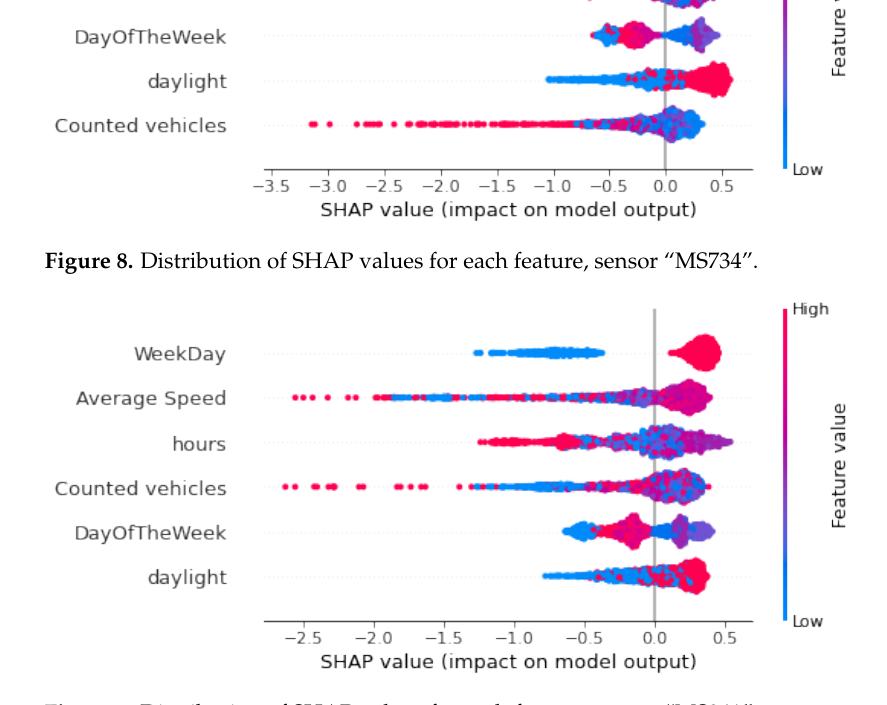
Figure 9. Distribution of SHAP values for each feature, sensor